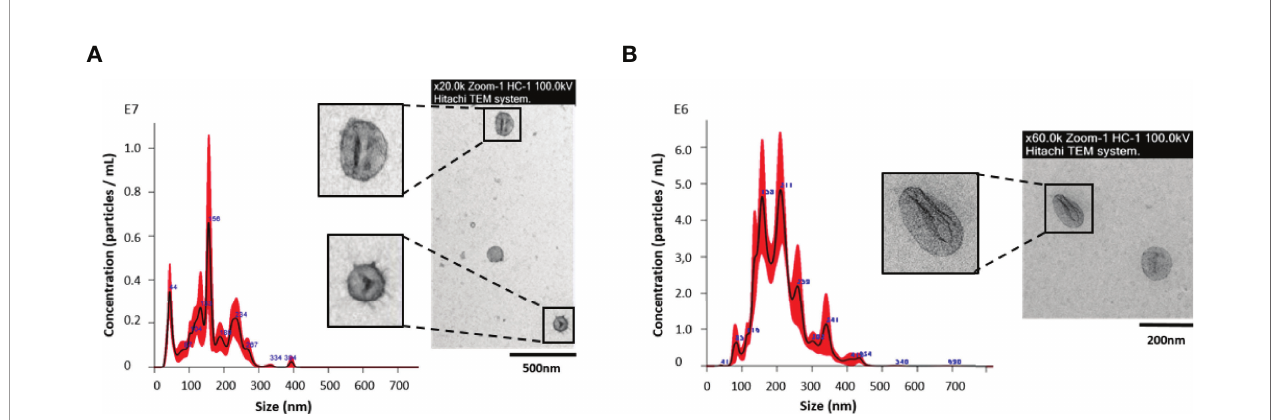
FIGURE 1 | Nanoparticle tracking analysis (NTA) and transmission electron microscopy (TEM) of extracellular vesicles (EVs) from (A) Fasciola hepatica eggs/ miracidia; and (B) F. hepatica NEJs, cultured up to 28 days, and collected as a pool. Each aliquot of EVs from NEJs and eggs, eluted in fractions 4 – 7 during SEC isolation, was analyzed by NTA in a NanoSight LM10 using samples diluted 1:50 and 1:80 respectively, to determine the size distribution and concentration. The insets show an image of a representative sample of each preparation processed for negative staining with 2% uranyl acetate as described in M&M and visualized with a Jeol JEM1010 transmission electron microscope at 80